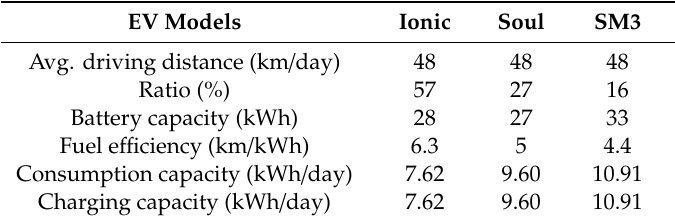
Table 12. The parameters for the EVs used in the simulation to predict charging load curve.